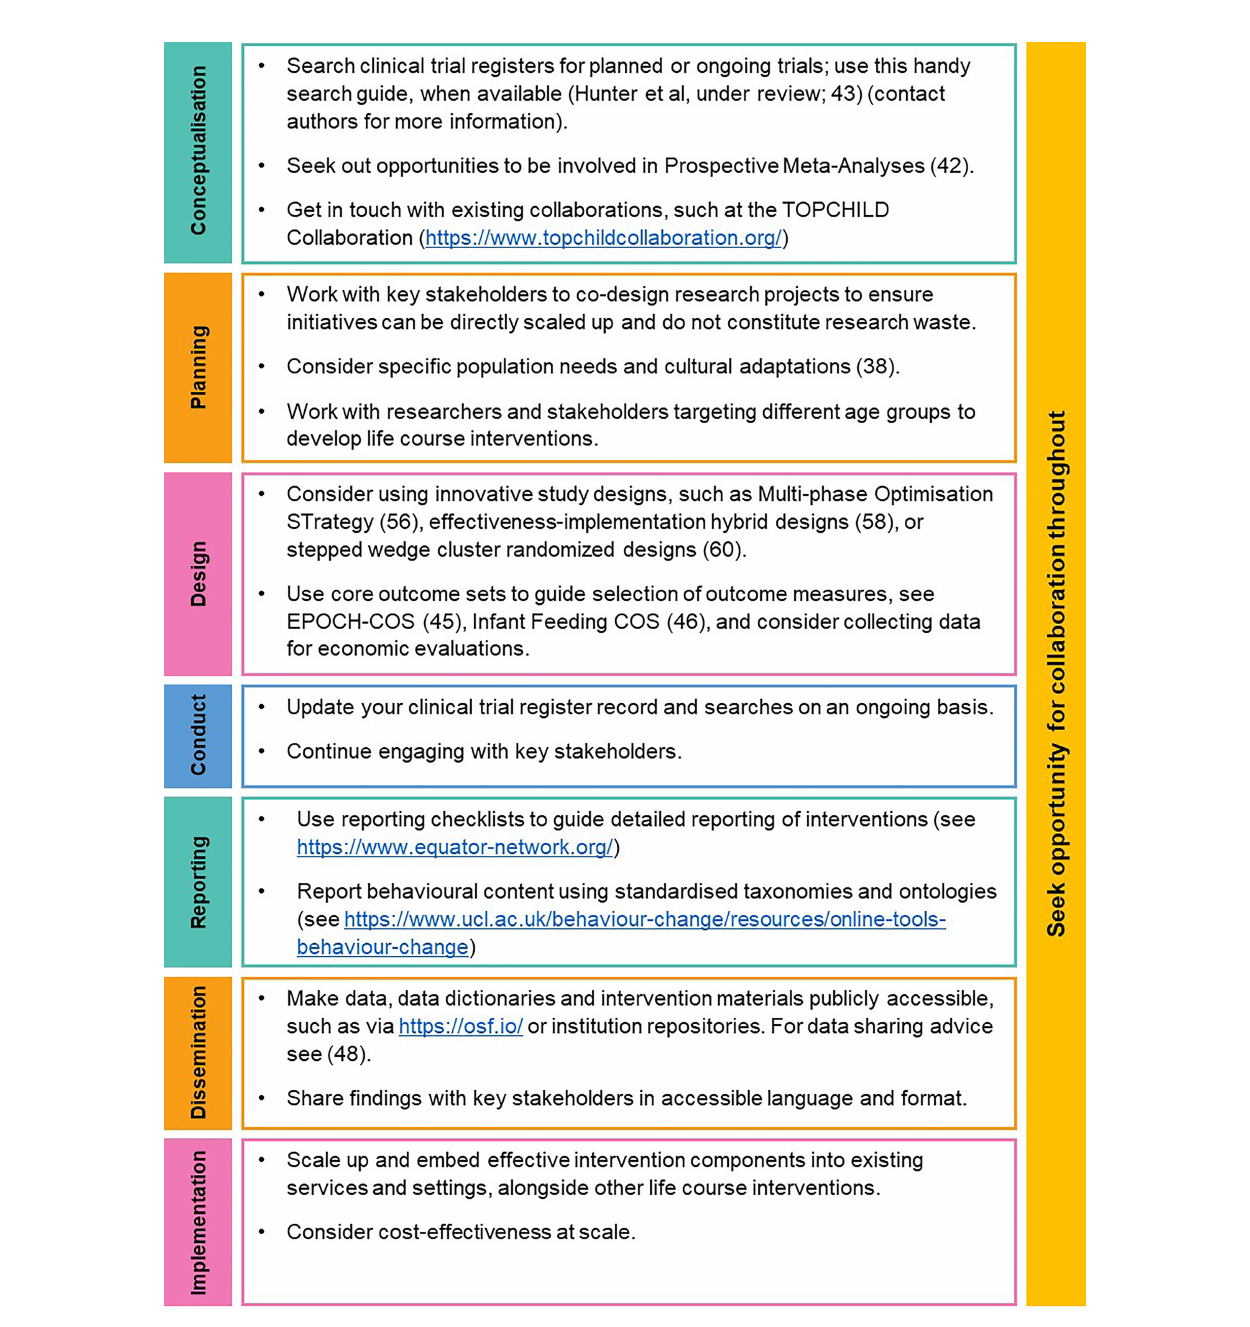
FIGURE 3 | How to apply proposed solutions throughout the research